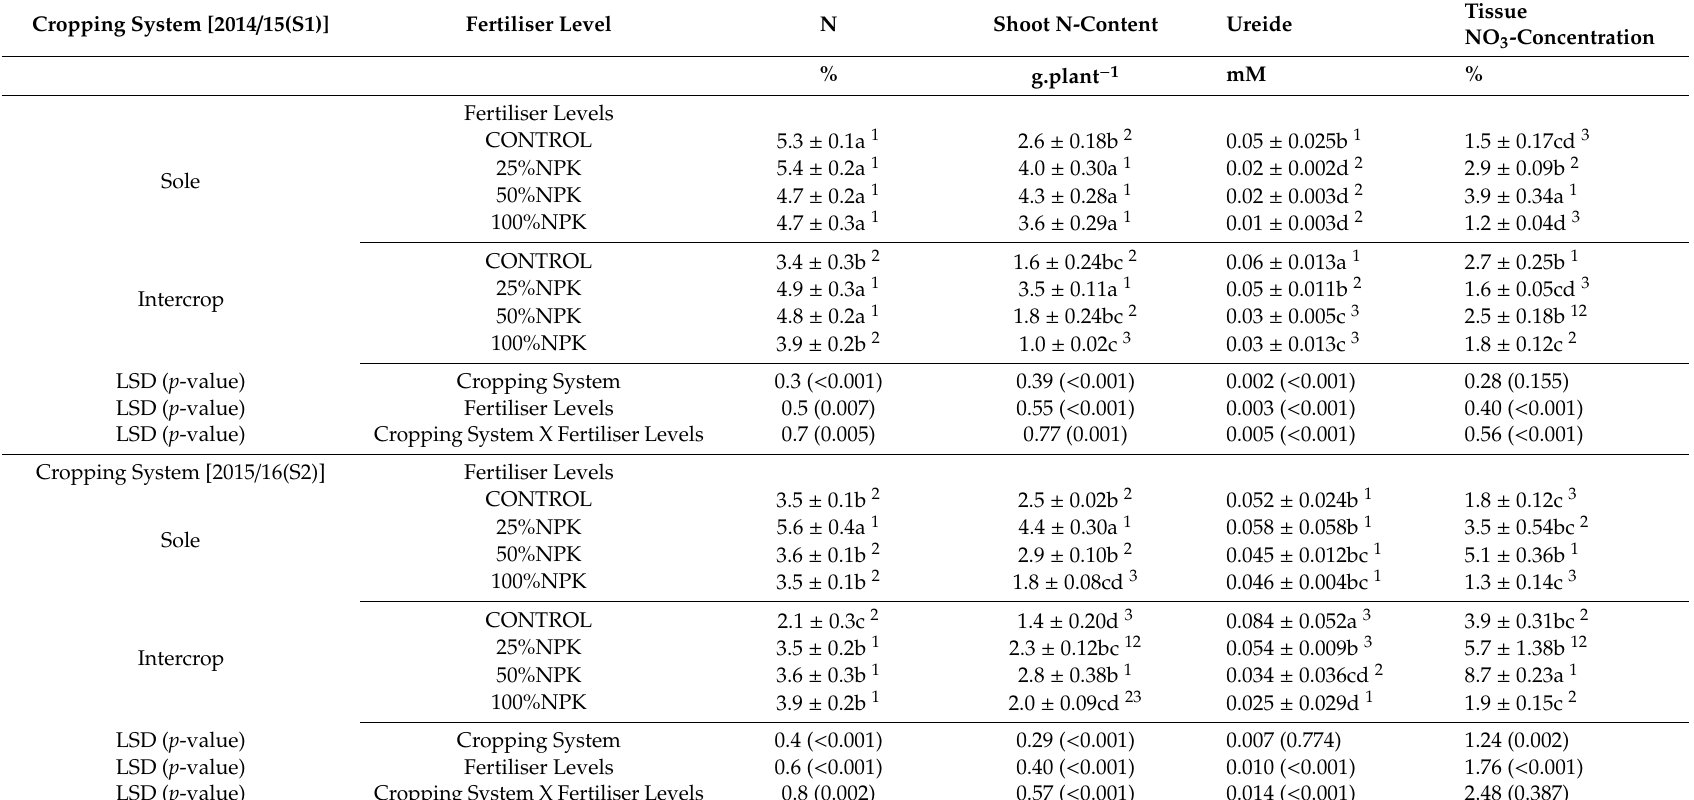
Table 2. Percentage N, shoot N-content, ureides and tissue NO 3 -concentration of cowpea fertilised with four di ff erent fertiliser (NPK) levels in 2014 / 15 (S1) and 2015 / 16 (S2)